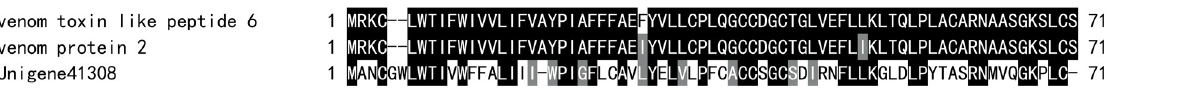
Fig 7. Alignment of the amino acid sequence of unigene 41308 with Mesobuthus eupeus venom toxin-like peptide-6 and venom protein 2. The GenBank accession numbers for venom toxin-like peptide-6 and venom protein 2 are ABR21046 and ABR21036, representatively. Black and gray indicate amino acids that are identical or highly conserved across all aligned sequences,